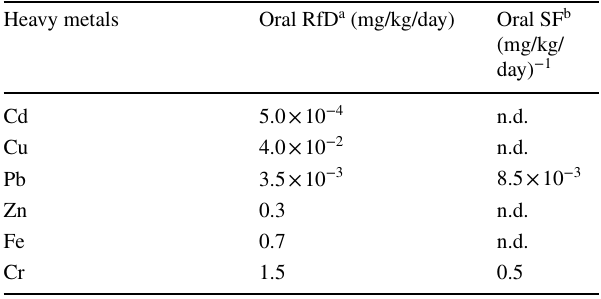
Table 3 The toxicity responses of each heavy metal as oral reference dose and slope factor